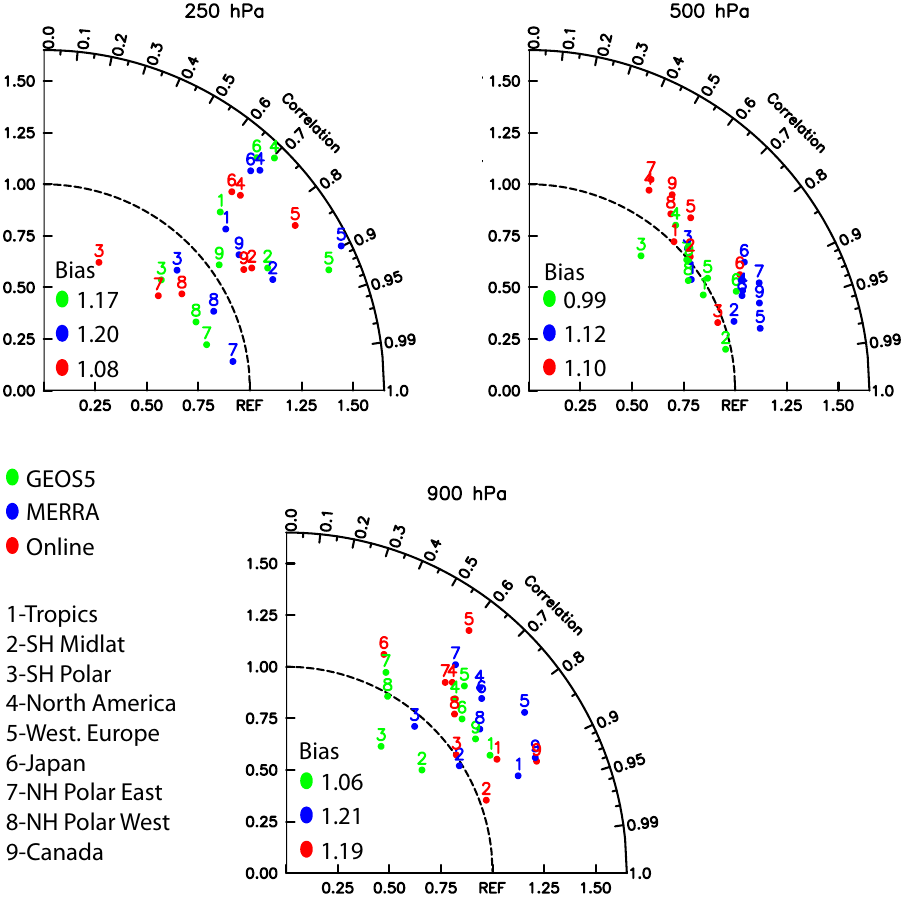
Fig. 6. Taylor diagram of modeled ozone against ozone sonde climatology (Tilmes et al., 2011) for 3 pressure levels; the radial distance indicates the normalized bias while the angle indicates the correlation of the average seasonal cycle. Averaging is done over the overlap period between the model simulations and the observations for each